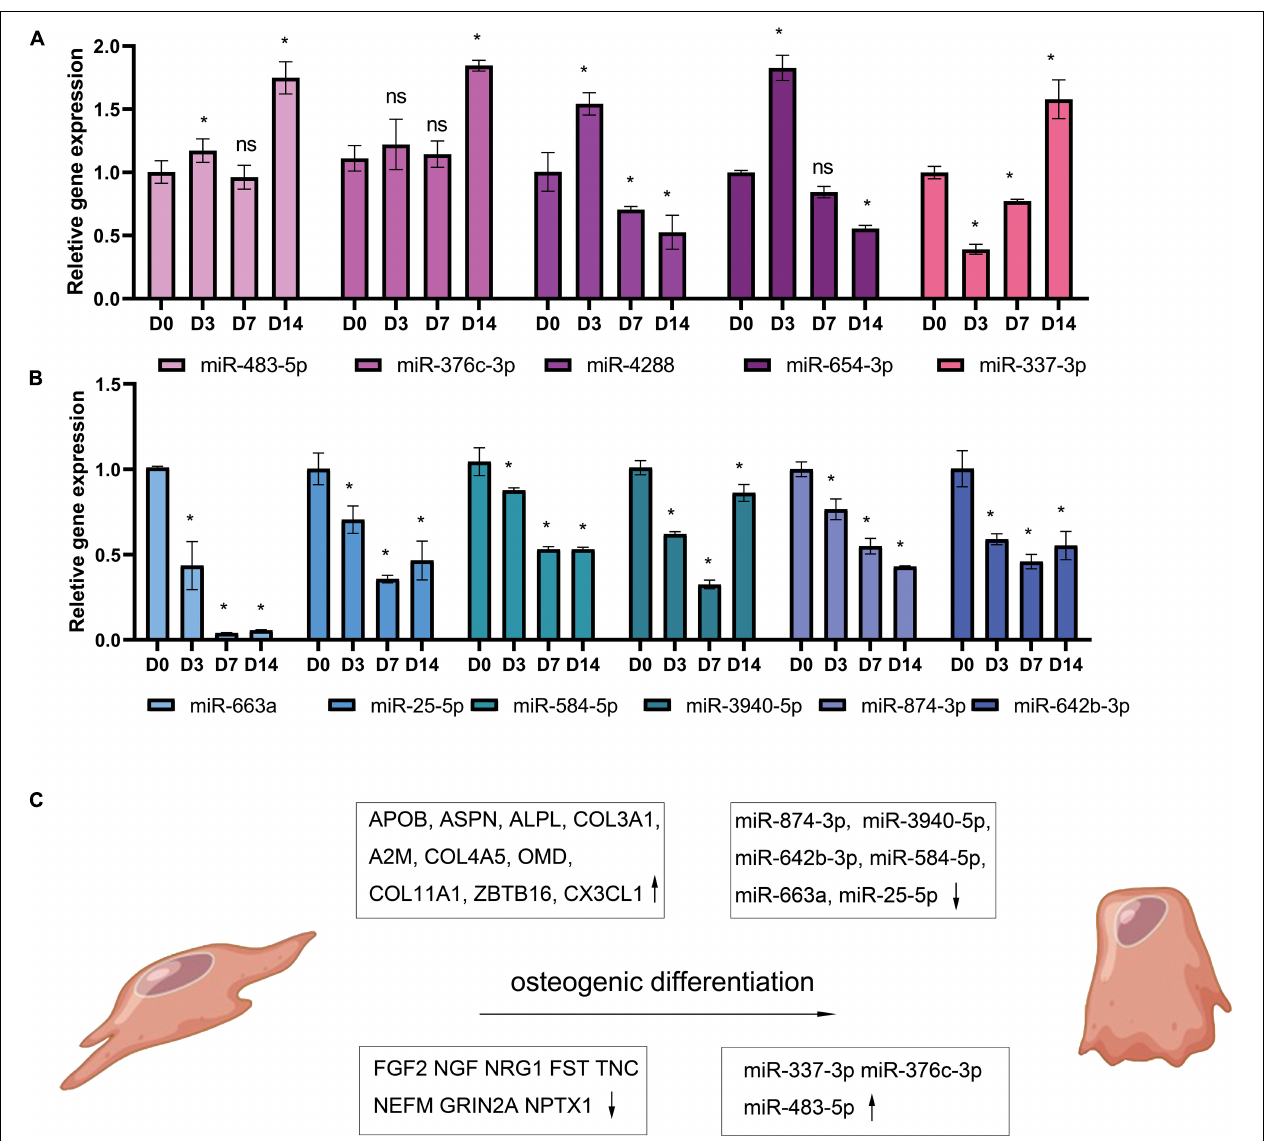
FIGURE 6 | Candidate miRNAs change during osteogenic differentiation of PDLSCs in vitro . PDLSCs cells were cultured in osteogenic induction medium for 0, 3, 7, 14 days and reverse transcribed with Stem-loop Method and then tested by qPCR. The histogram shows qPCR results of five up-regulated miRNAs (A) and 6 down-regulated miRNAs (B) . Demonstration diagram of hub genes and miRNAs change patterns verified during PDLSCs osteogenic differentiation in vitro (C) . * p <